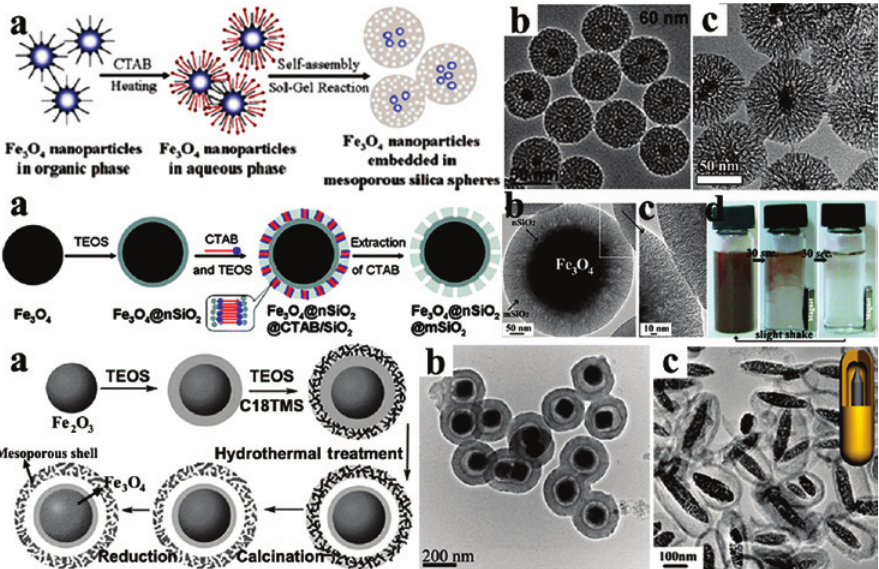
Figure 6: Mechanisms of magnetic core entrapment in MSN shells. (a) Schematic construction mechanism; (b) TEM image of magnetic core nanoparticles; (c) TEM image of nanoparticle after pore formation. Reused from Reference [28] with permission of John Wiley and Sons’